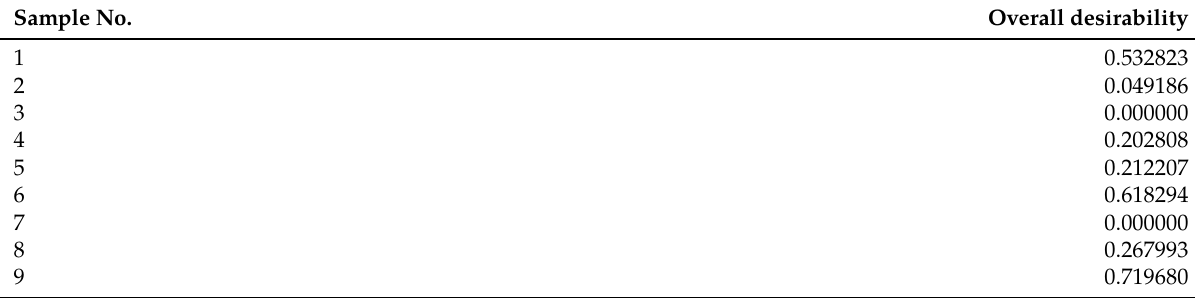
Table 5: Overall desirability values. Sample No.